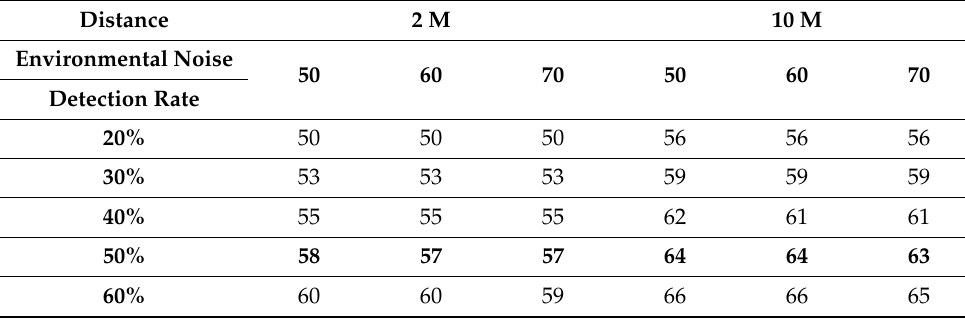
Table 3. Estimated SPL (dBA) of high-frequency warning sound.